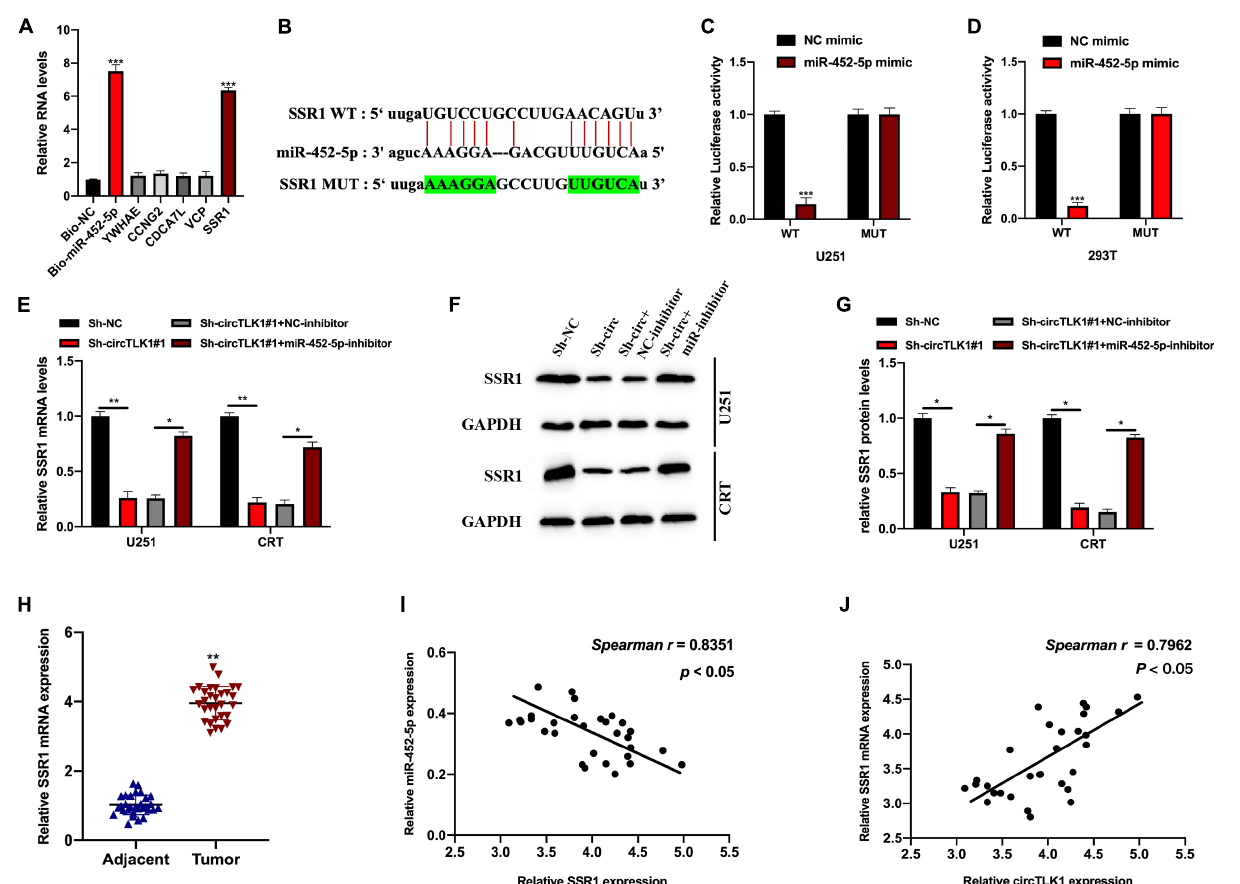
FIGURE 6 | CircTLK1 regulates SSR1 expression through sponging miR-452-5p. PITA database (http://genie.weizmann.ac.il/pubs/mir07/mir07_dyn_data.html) and DIANA-microT (http://diana.imis.athena-innovation.gr/DianaTools/index.php?r=microT_CDS/index) with CLIP Data, strict stringency ( ≥ 5), and degradome data, high stringency ( ≥ 3), was used. (A) qRT-PCR was used to assess potential binding mRNAs expression and bio-miR-452-5p expression in U251 cells. (B) The WT and MUT binding sites between SSR1 and miR-452-5p. (C,D) Relative luciferase activities in NC mimic, miR-452-5p mimic, and reporter vectors containing SSR1 WT and Mut sequences transfected into 293T and U251 cells were measured. (E–G) The protein and mRNA expressions of SSR1 in U251 and CRT pretreated with Sh-NC, Sh-TLK1#1, Sh-TLK1#1 + NC-inhibitor, and Sh-TLK1#1 + miR-452-5p-inhibitor were measured using qRT-PCR and Western blot. All experiments were performed in triplicates. (H) SSR1 expression in glioma tissues was assessed using qRT-PCR. (I,J) Spearman analysis was used to calculate the association between SSR1 and circTLK1 or miR-452-5p. *p < 0.05, **p < 0.01, ***p <